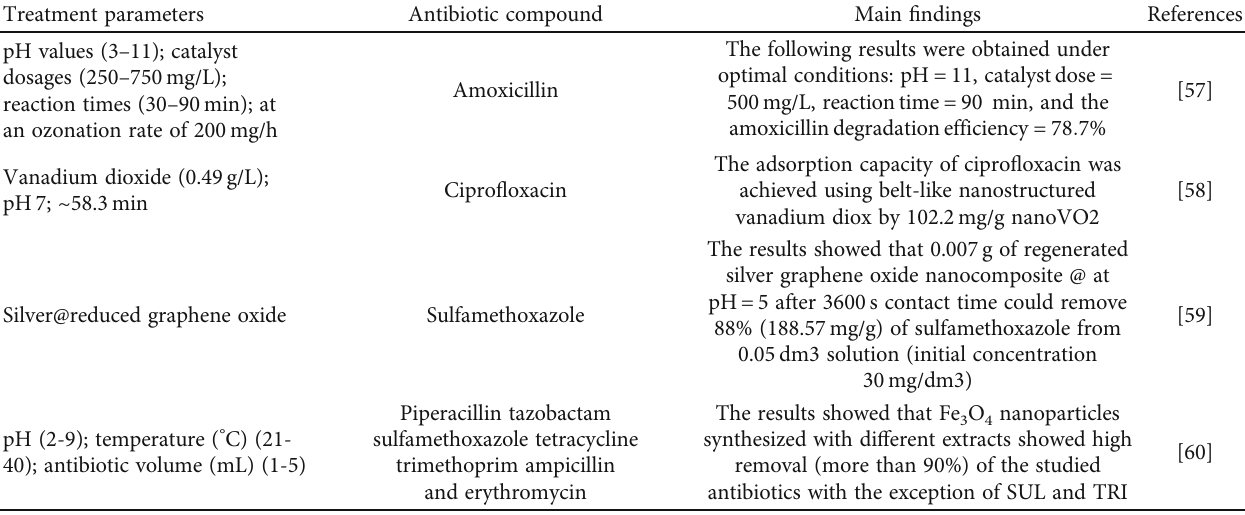
Table 4: Summary of studies performed using nanotechnology to the removal of di ff erent types of antibiotics. Treatment